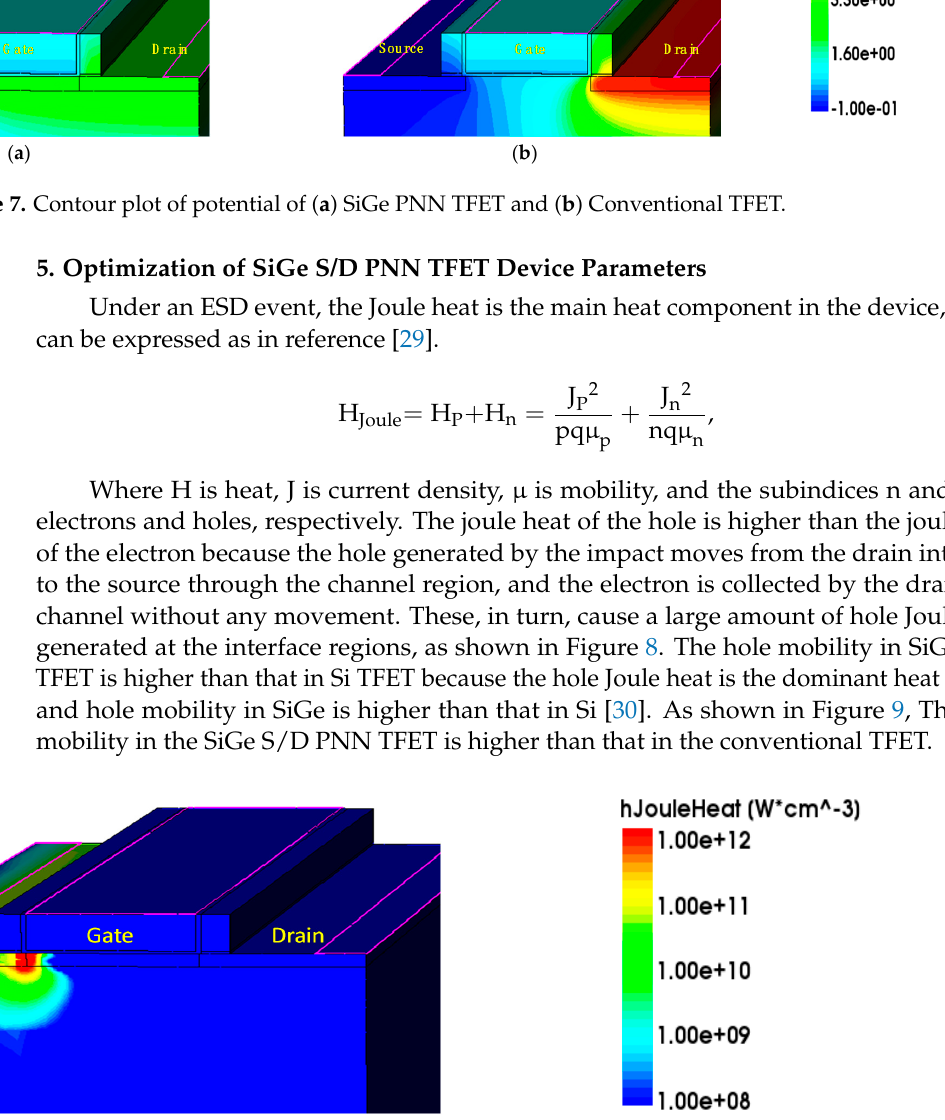
Figure 6. Contour plots of ( a ) total current density, ( b ) hole current density and ( c ) electron current density of PNN TFET and ( d ) total current density, ( e ) hole current density, and ( f ) electron current density of Conventional TFET at 90 ns under 1 mA/ μ m TLP current. For clarity, only part of the device is shown.